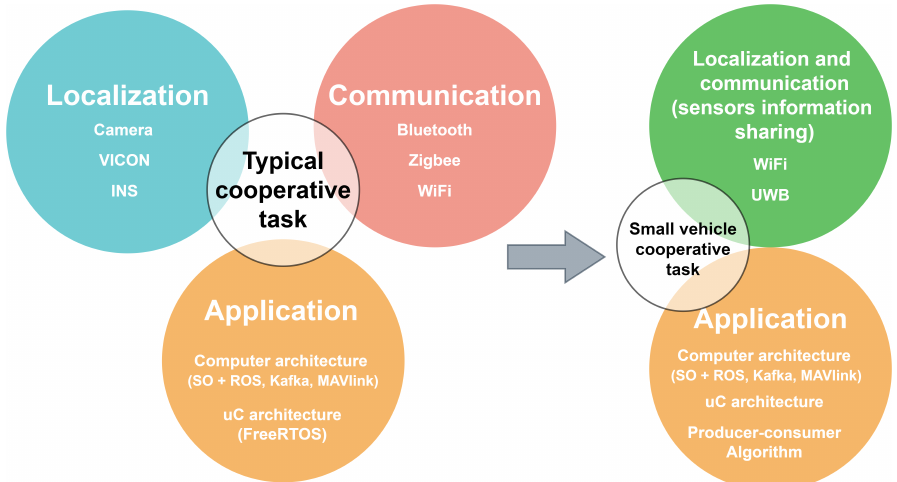
Figure 1. Comparison of software-oriented architecture ( left-side ) and proposed architecture ( right-side ).